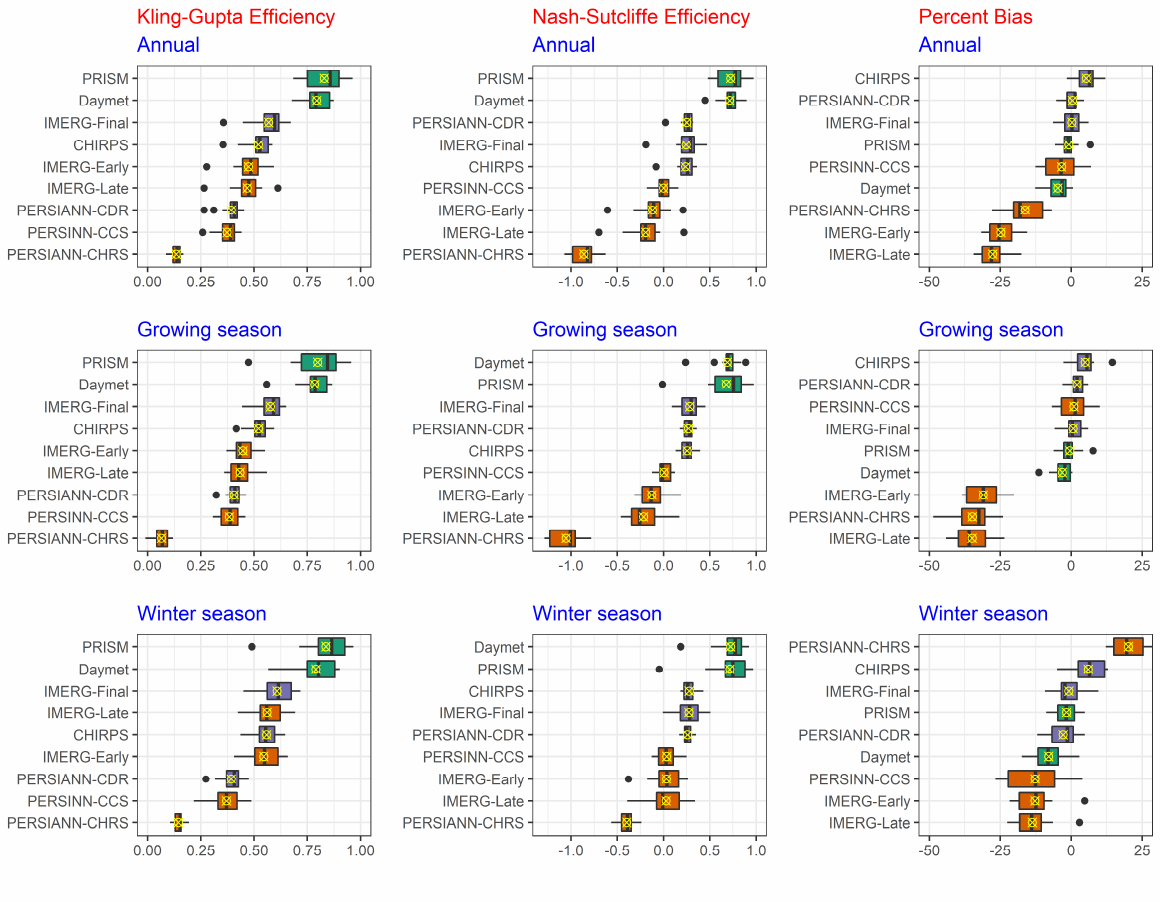
Figure 3. Point-to-grid daily precipitation comparison statistics (2000–2019) for the Bosque watershed. In situ daily precipitation at an NCDC weather station (Figure 1) was compared with the estimated precipitation in the corresponding grid of a gridded precipitation dataset. The boxes’ yellow circle cross and black vertical lines denote the mean and median, respectively.